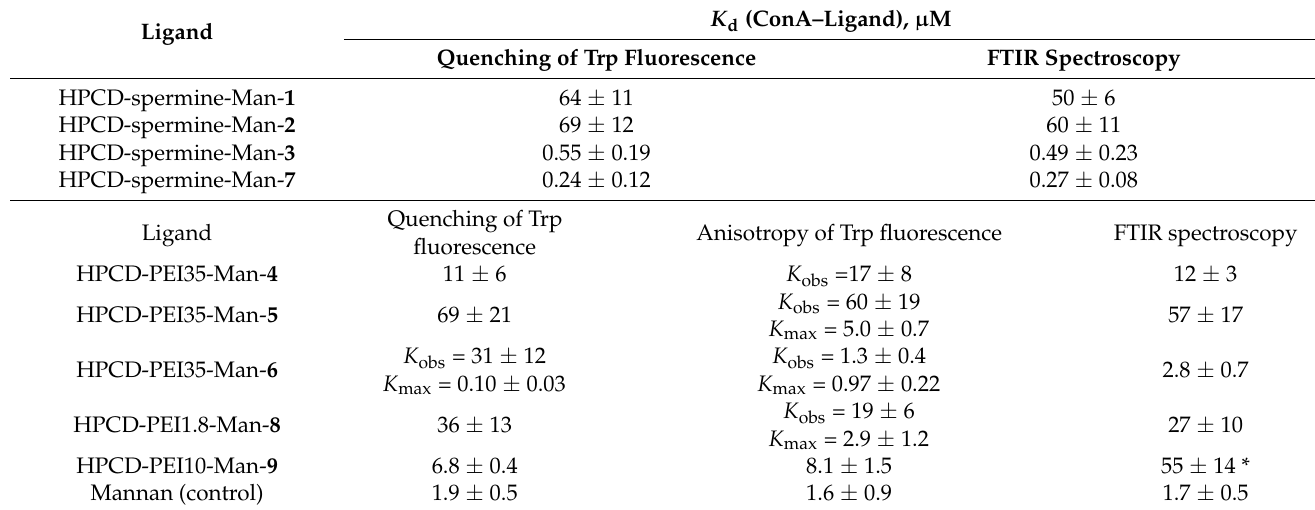
Table 2. Dissociation constants of ConA–ligand complexes determined by fluorescence methods and FTIR spectroscopy. The conditions are given in the Methods